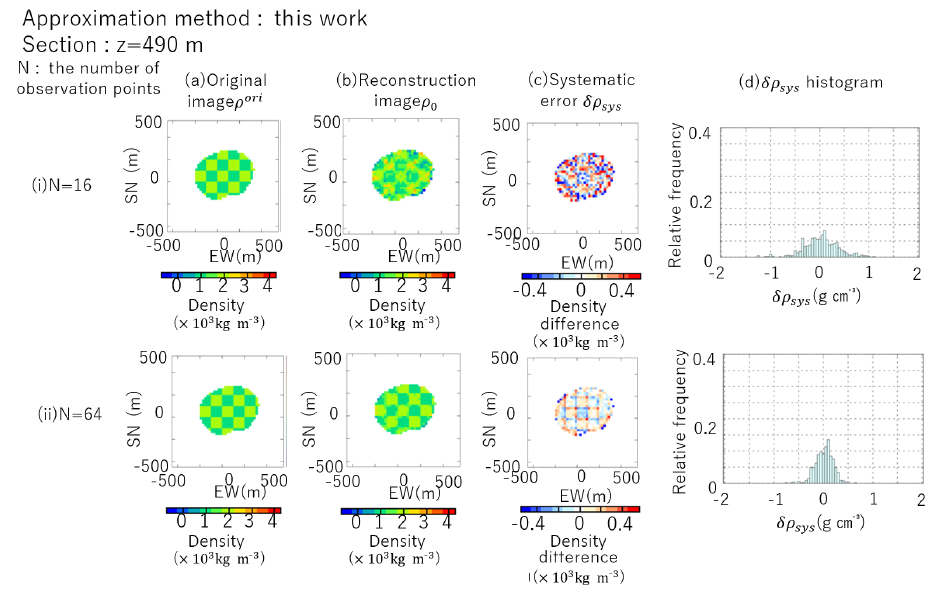
Figure 5. An example of the reconstruction results. All plots were calculated with the results from path length normalized approximation. The altitude of each section is 490m. Plots are only from the mountains. (a) Original image: ρ ori (x,y,z) ; (b) reconstruction image: ρ rec (x,y,z) ; (c) systematic error: δρ sys (x,y,z) ; (d) δρ sys histogram: the relative frequency of systematic error. The mean of this plot is µ sys , and the sample standard deviation is σ sys .